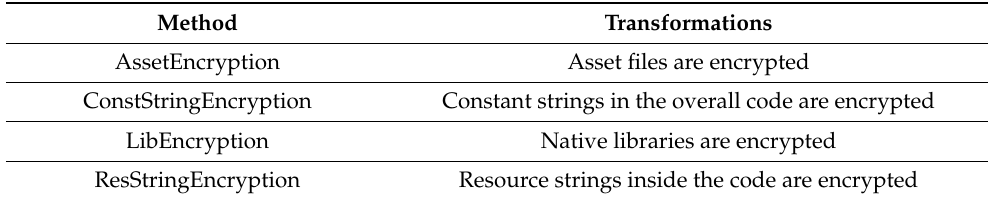
Table 3. Non-Trivial Obfuscation